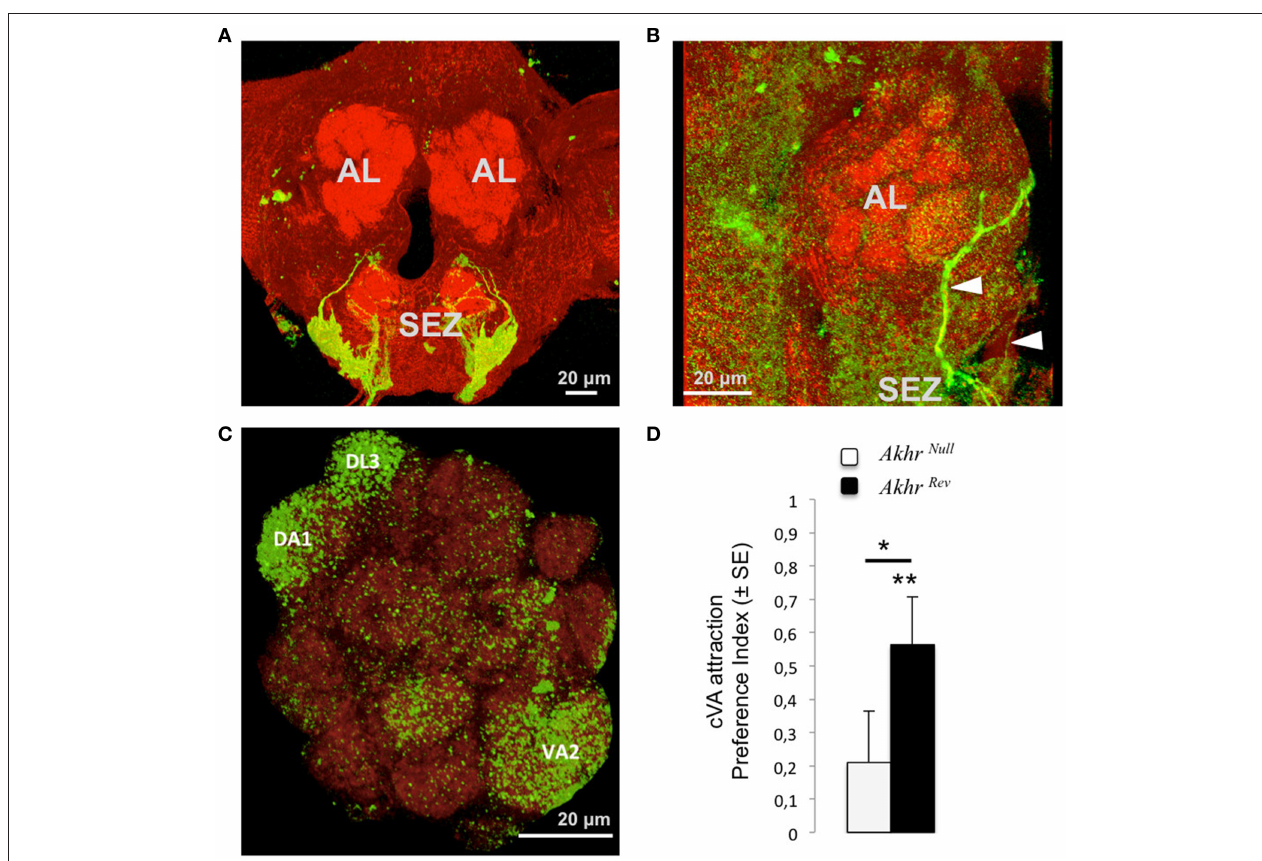
FIGURE 2 | Effect of AKHR on pheromone perception. (A–C) Innervation pattern of AKHR-sensitive neurons (using AKHR-Gal4 to drive GFP expression, green) within a background of anti-synapsin staining (red). (A) Expression in the subesophageal zone (SEZ). (B) Arrowheads show the projections of the AKHR-expressing neurons from the SEZ to the antennal lobes (AL). (C) The glomeruli in which a consistent expression of AKHR was observed are annotated. (D) Attraction to cVA for Akhr null and Akhr rev males. A positive preference index shows a preference for a blend of cVA and vinegar over vinegar alone. Asterisks show significant attraction to cVA (above bars) or significant differences between flies (between bars), * p < 0.05 , ** p < 0.01 . Scale bar in each confocal image represents 20 µ m.